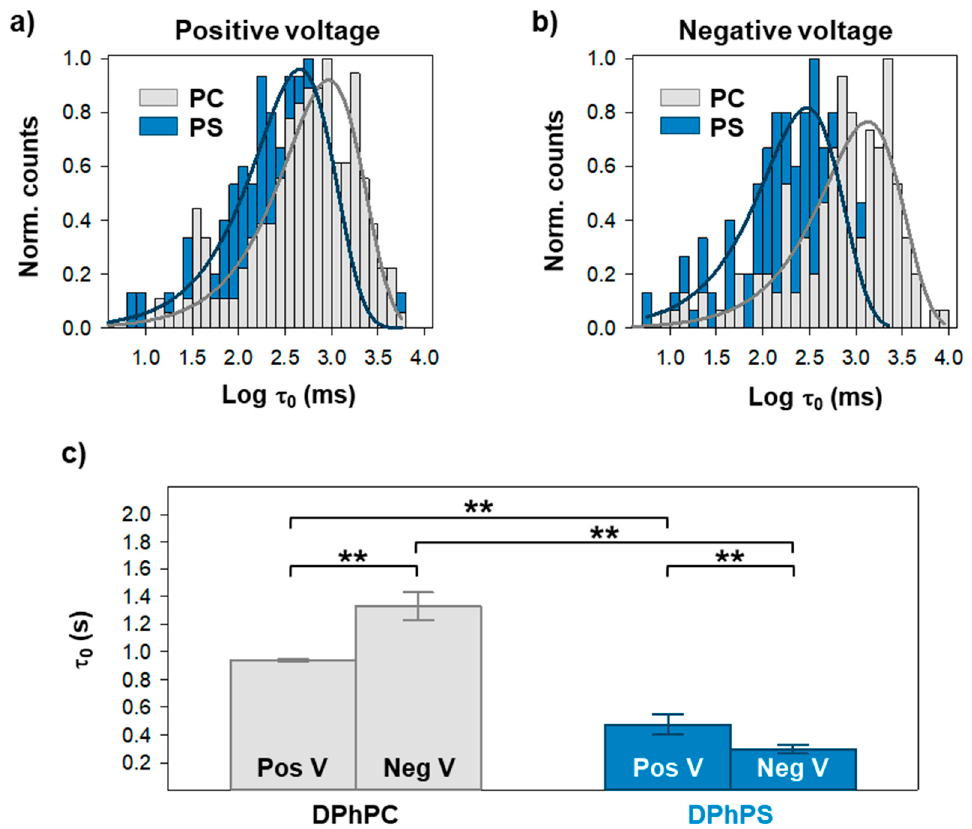
Figure 3. A negatively charged membrane accelerates closure of first OmpF monomer. Logarithmically binned histograms of the time the channel spends in the open conformation under a positive ( a ) or a negative ( b ) applied voltage when inserted in a neutral or negatively charge membrane, as indicated. Solid lines are exponential fittings. The characteristic times obtained from exponential fittings are shown in ( c ). See Figure S1 for the distributions in ( a ) and ( b ) displayed individually. In ( c ), significance between mean closure times was determined with a one-way ANOVA significance test. A Holm–Sidak post hoc test was used for pair-wise comparison (**: p < 0.01). See Materials and Methods for more details.